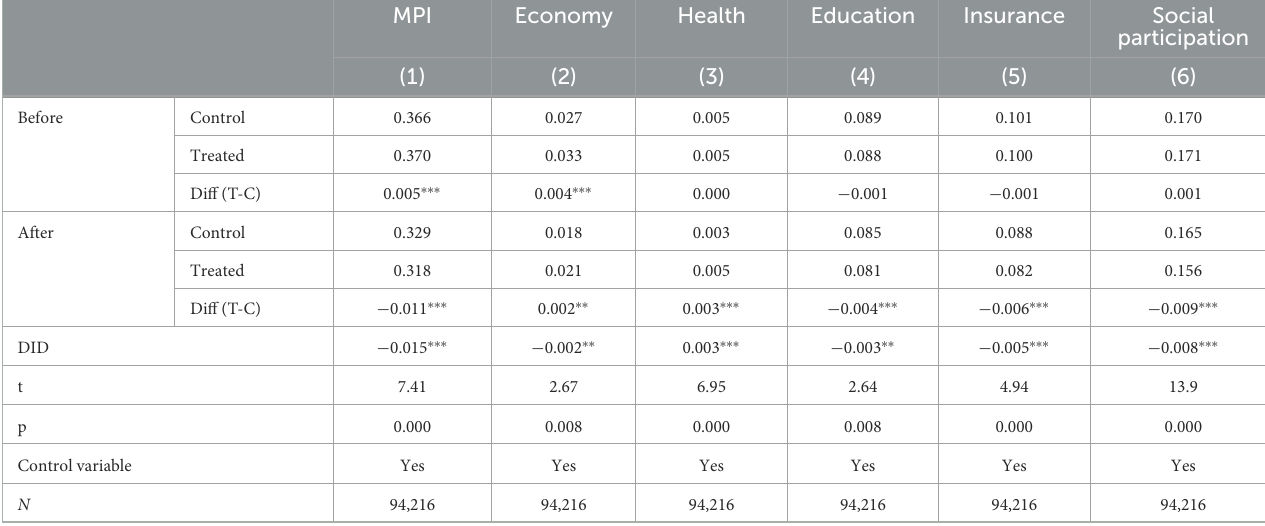
TABLE 8 Effect of employment services on MPI and different poverty dimensions.